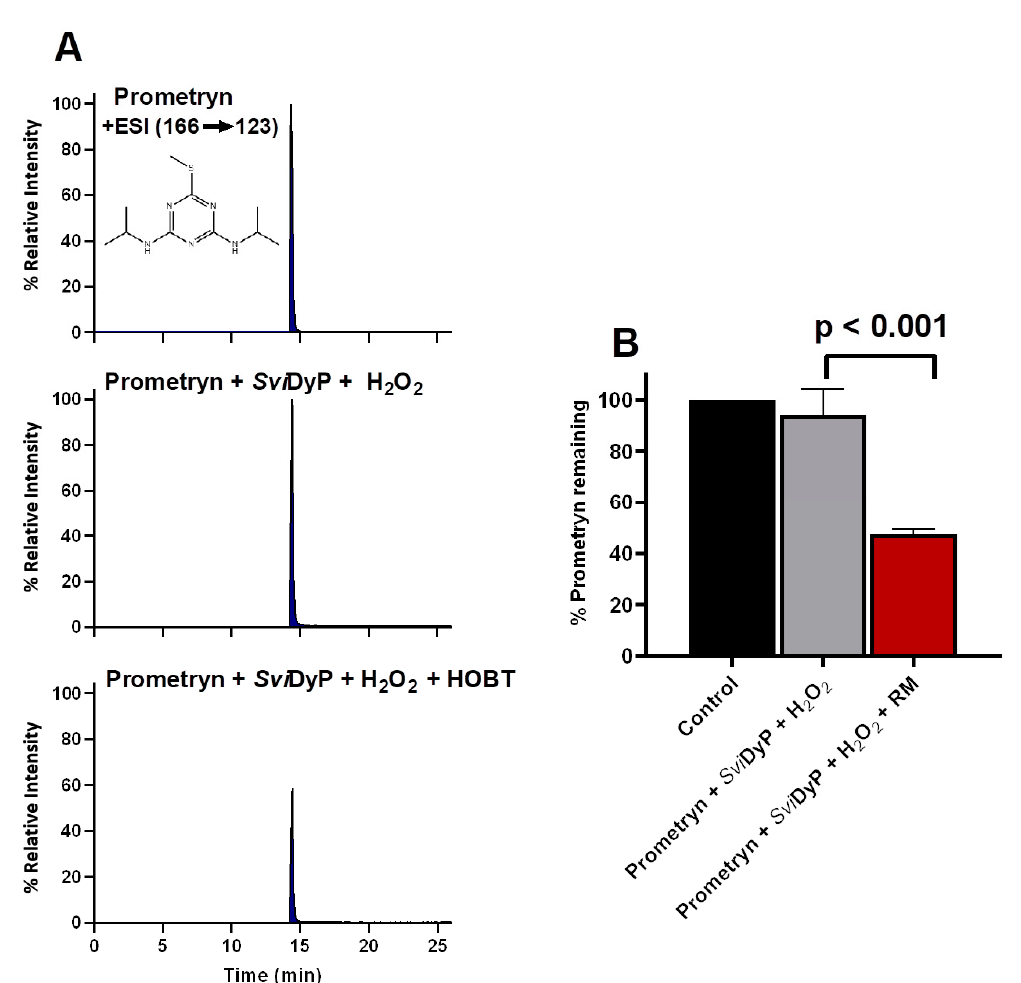
Figure 6. ( A ) MRM chromatograms extracted for Prometryn treated with Svi DyP with and without HOBT. ( B ) shows the percentage of Prometryn remaining after both treatments. Reaction conditions: [EP] = 4 ppm, [ Svi DyP] = 2.8 µ M, [H 2 O 2 ] = 0.25 mM, pH = 4.